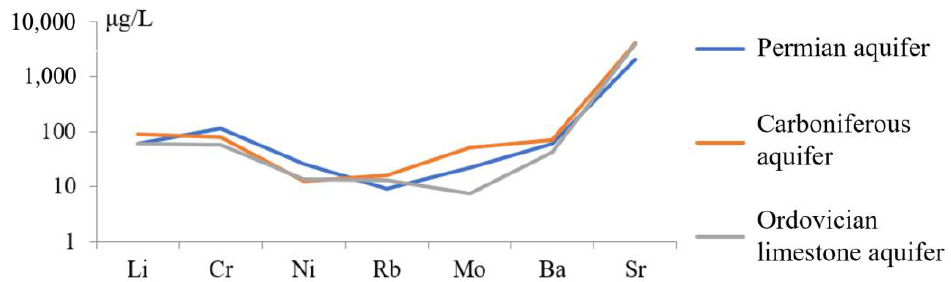
Figure 17. Characteristic Trace Element Profile of Main Water inrush Aquifers in the Mining Area.